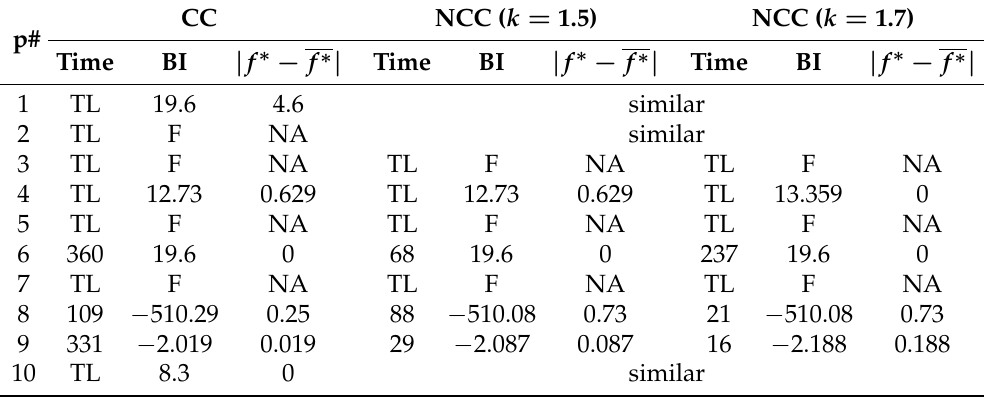
Table 9. Results of Solving MILP Problems Obtained from MIQCP Instances, Produced by CC and NCC Models Using 11